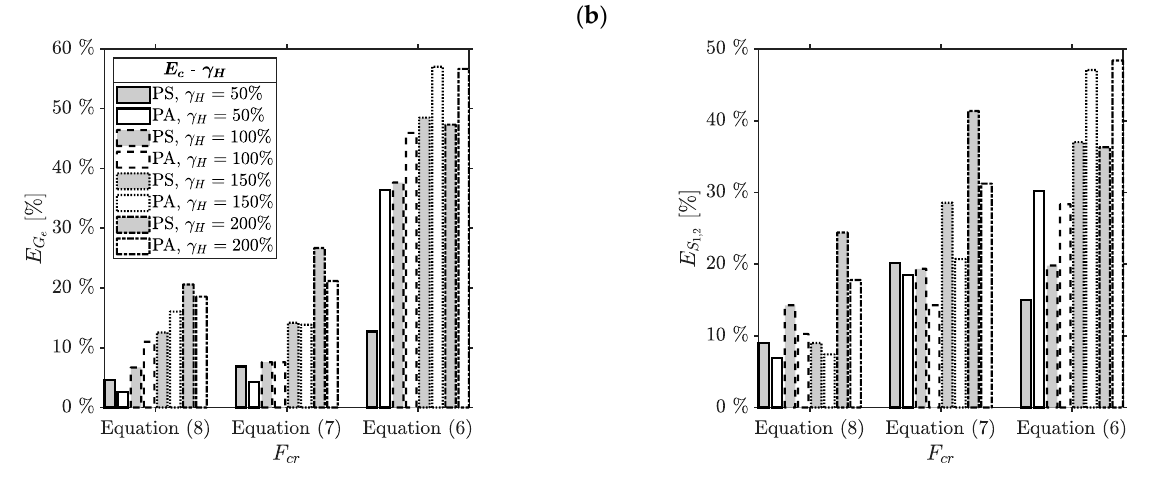
Figure 8. Percentage difference between analytical and numerical models on the ψ function at four different levels of shear strain and: ( a ) shear modulus of the rubber; ( b ) primary and secondary shape factors.